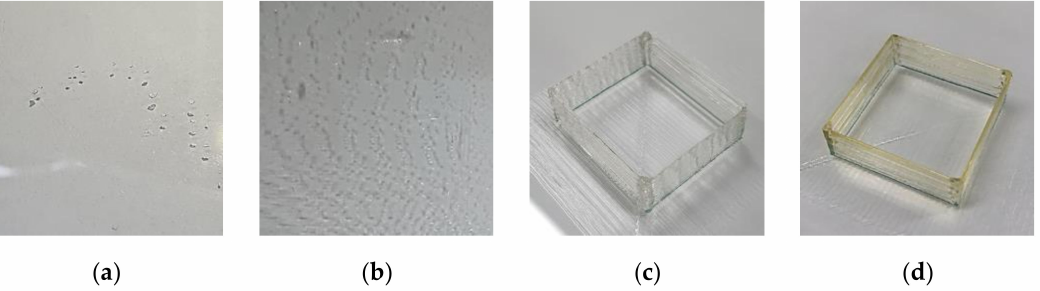
Figure 5. Printed specimens according to the extrusion temperature: ( a ) 130 ◦ C, ( b ) 140 ◦ C, ( c ) 150 ◦ C, ( d ) 160 ◦